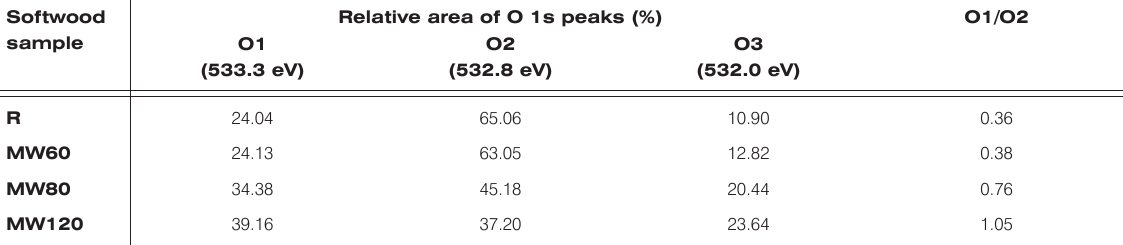
Table 5. Subpeak area fractions of O1s and ratio of O1/O2.